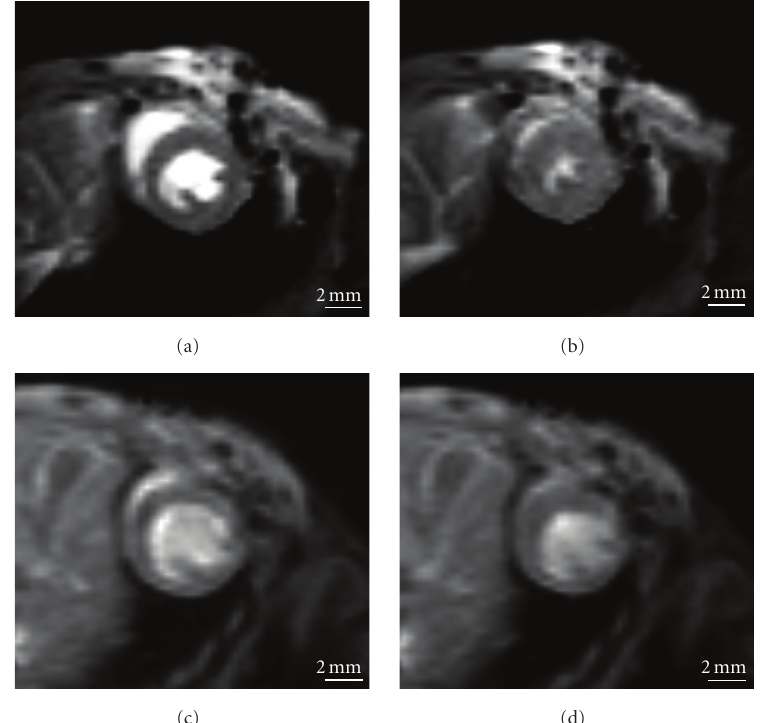
Figure 2: Short-axis cine magnetic resonance imaging of the mouse heart. Mouse heart in cardiac cine magnetic resonance imaging 1 week after sham operation ((a): diastolic, (b): systolic) and 60 min ischemia ((c): diastolic, (d): systolic).